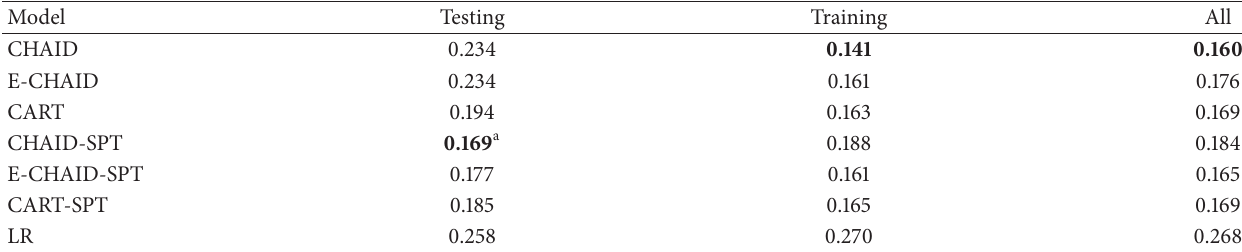
Table 4: Risk estimation of the DT and LR models.